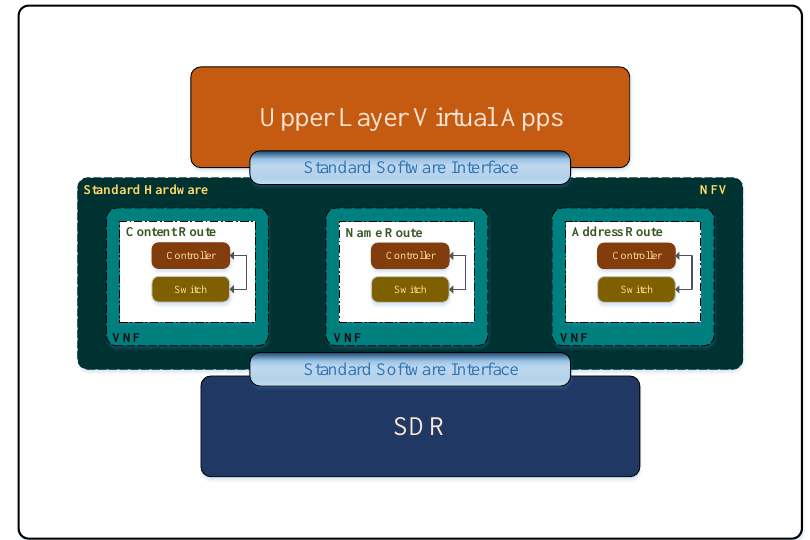
Figure 3. Implement of MMNET multi-modal routing and forwarding. Each route is organized in the form of virtual machine (vnf), which does not affect each other and runs independently.